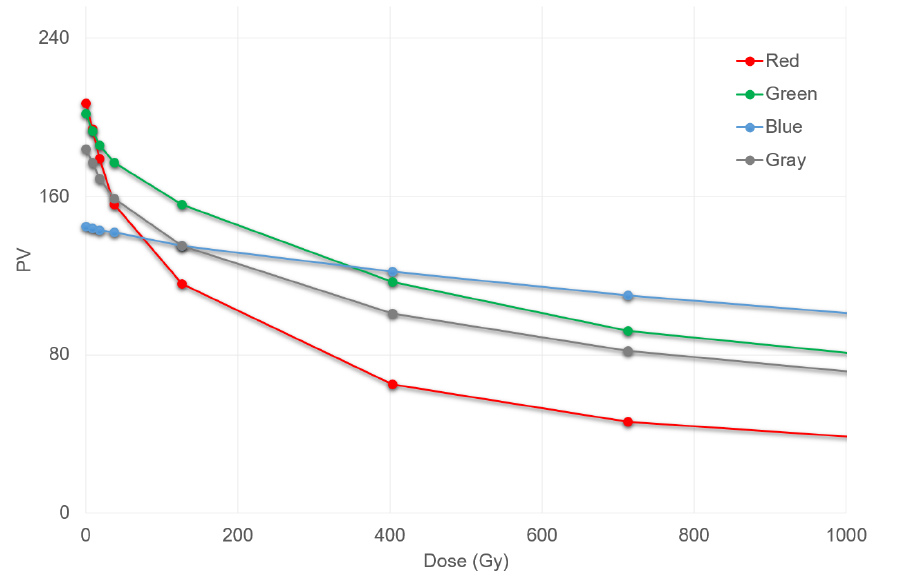
Figure 5. Response of the Gafchromic™ HD-V2 film to the different color